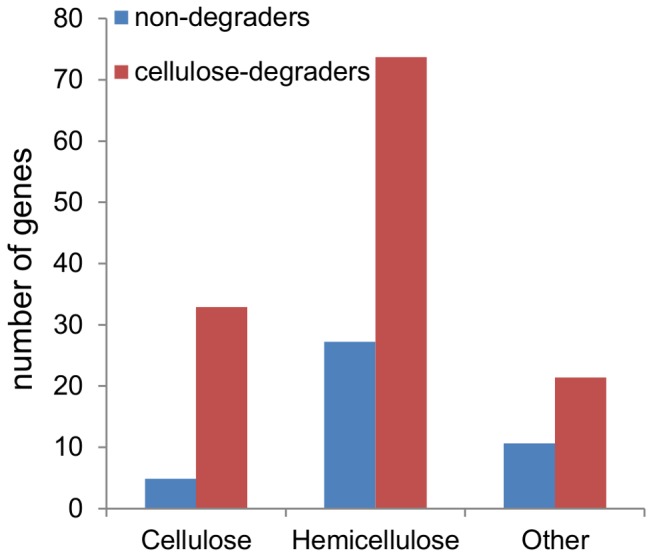
Average number of genes encoding glycoside hydrolase and LPMO enzymes in the 39 fungi.The average number of genes predicted to encode cellulose-degrading activities (EC 3.2.1.4, 3.2.1.21, EC 3.2.1.91 and EC 3.2.1.176 and LPMOs), hemicellulose-degrading activities (EC 3.2.1.37, 3.2.1.151, 3.2.1.8, 3.2.1.55, 3.2.1.23, 3.2.1.59, 3.2.1.131, 3.2.1.177, 3.2.1.78, 3.2.1.67, 2.4.1.183, 3.2.1.25, 3.2.1.31, 3.2.1.15, 3.2.1.39, 3.2.1.58, 3.2.1.63, 3.2.1.22, 3.2.1.99, 3.2.1.75, 3.2.1.52, 3.2.1.6, 3.2.1.106, 3.2.1.51, 3.2.1.113, 2.4.1.18, 2.4.1.25, 3.2.1.28, 3.2.1.45, 3.2.1.18, 3.2.1.3, 3.2.1.26, 3.2.1.24, 2.4.1.20, 3.2.1.40 and 3.2.1.171) or other activities (EC 3.2.1.1, 3.2.1.20, 3.2.1.10, 3.2.1.165, 3.2.1.132, 3.2.1.14, 3.2.1.145, 3.2.1.89 and 3.2.1.164) in the cellulose-degraders and non-cellulose degraders. The division of enzyme activities (EC numbers) on cellulose-degradation, hemicellulose-degradation or other was described previously [2].